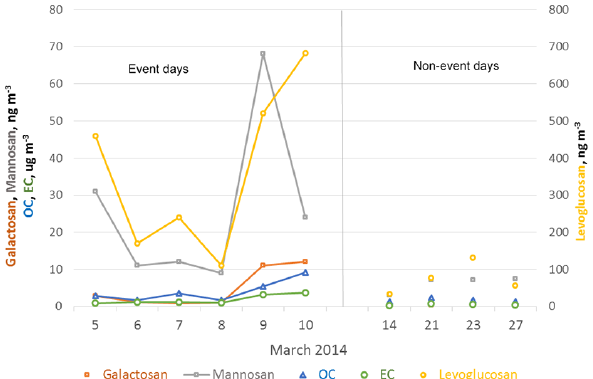
Figure 3. Average daily concentration during event days (from 5 to 10 March 2014) and non-event days (14, 21, 23 and 27 March 2014) for levoglucosan, galactosan, mannosan (in ngm − 3 ) and for elemental carbon (EC) and organic carbon (OC) in µgm − 3 .